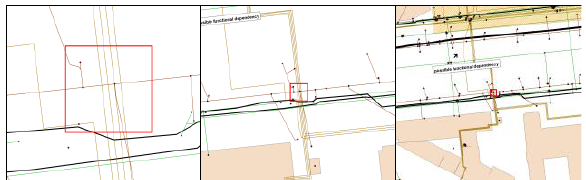
Figure 4. object density at scales (from left to right) 1:60; 1:300; 1:800 – lines are displayed by 1pt and points by 4pt (red square = 6m x 6m)